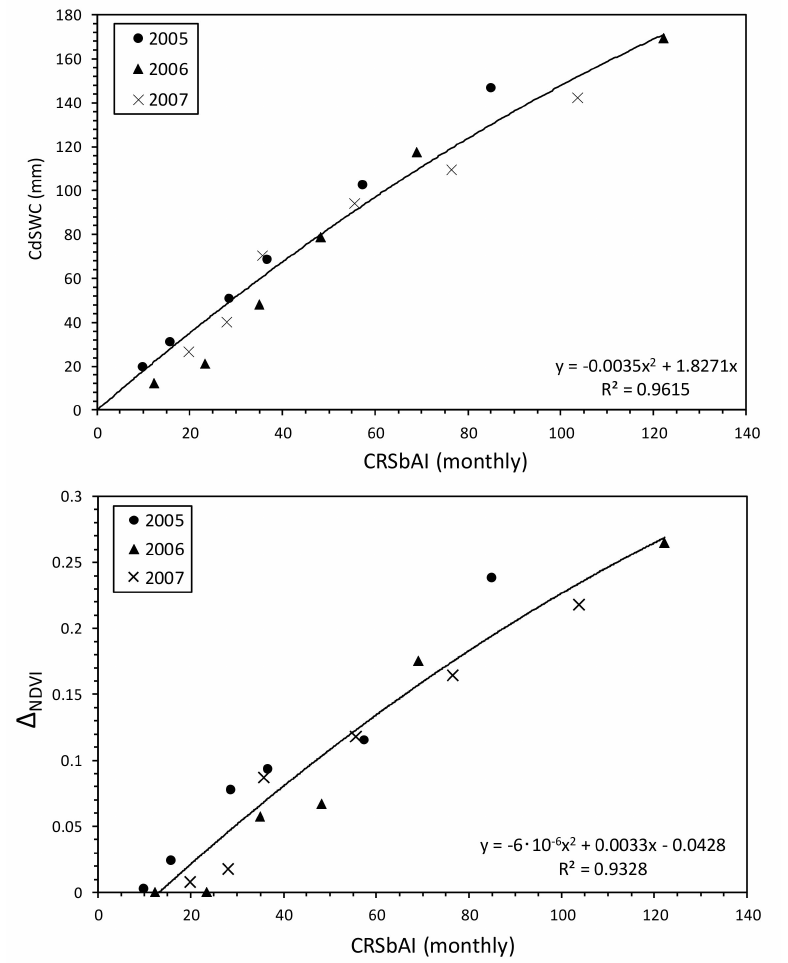
Figure 6. Relationships of CRSbAI (monthly) with CdSWC and ∆ NDVI in Shenmu from 2005 to